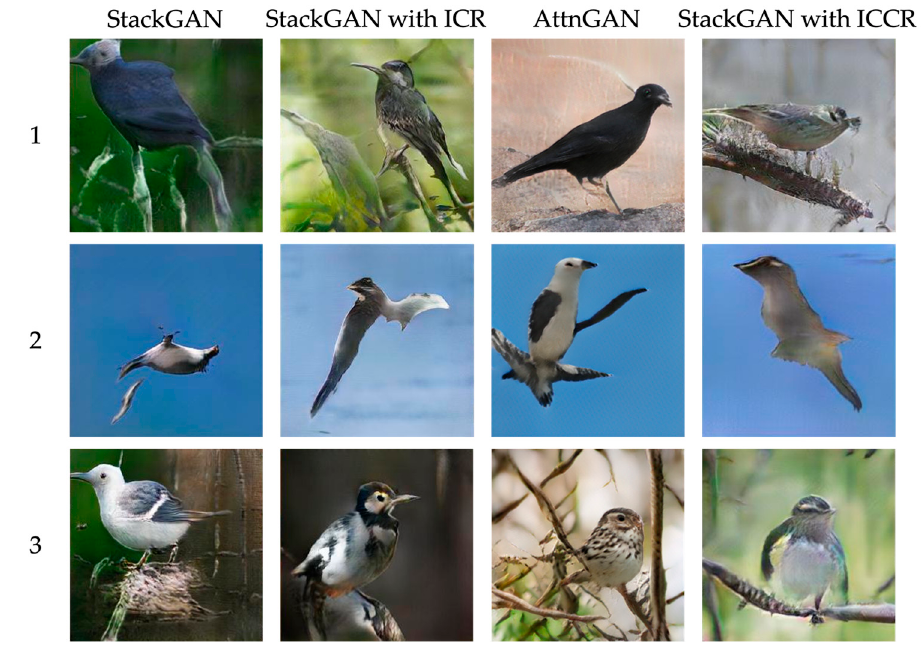
Figure 8. Images generated by each model.